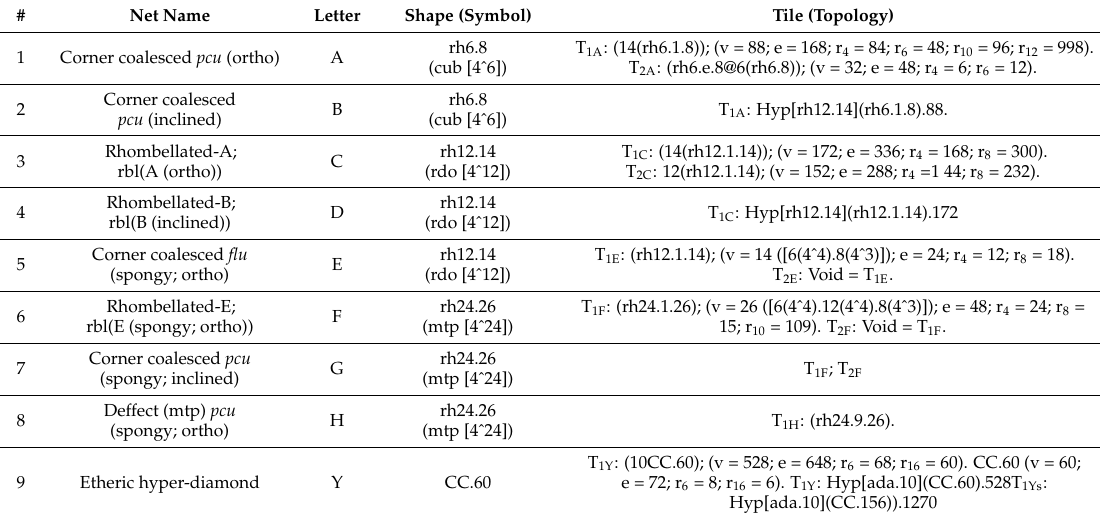
Figure 4. Tiles in the rhombellated nets of Figure 3. Table 1. Names of structures, assumed letter, shape, symbol and tile topology.